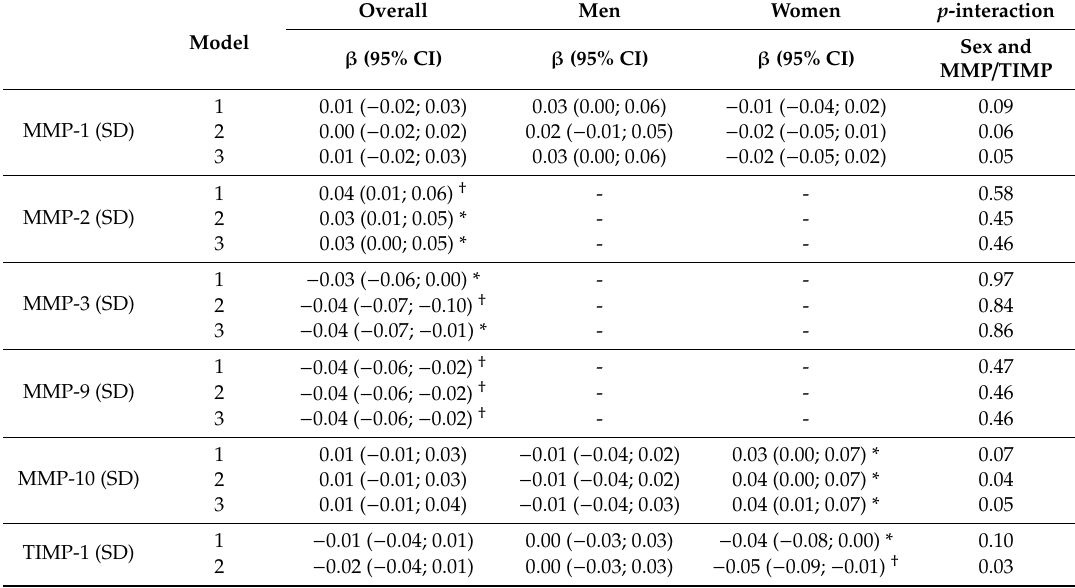
Table 2. Associations of serum MMPs and TIMP-1 with Ln left atrial volume index: overall and stratified to sex (linear regression, n = 674).